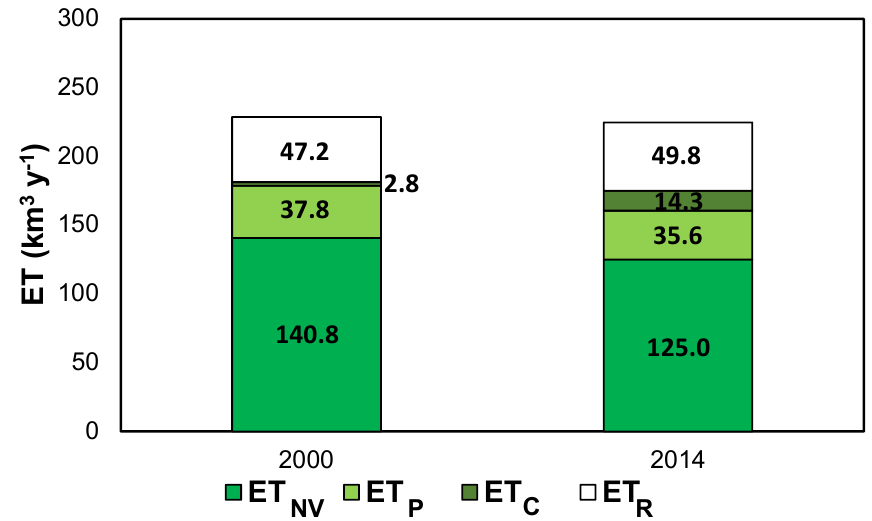
Figure 3. Changes in contributions to evapotranspiration (ET) for natural vegetation (ET NV ), pasture (ET P ), cropland (ET C ) and residual landscapes (ET R ) in the Xingu Basin of Mato Grosso in the 2000, and 2014 hydrologic years (September–August). Values obtained through the bottom-up approach as described in the text.